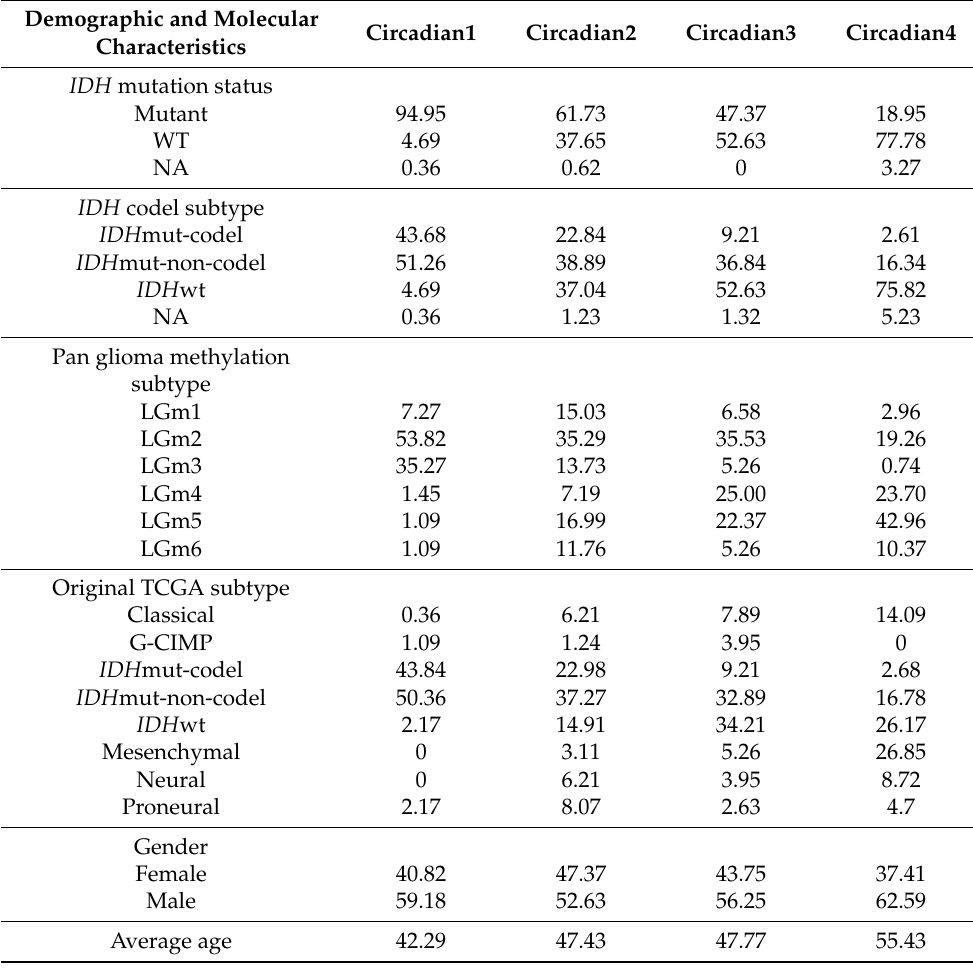
Table 1. Unsupervised consensus clustering based on 13 clock